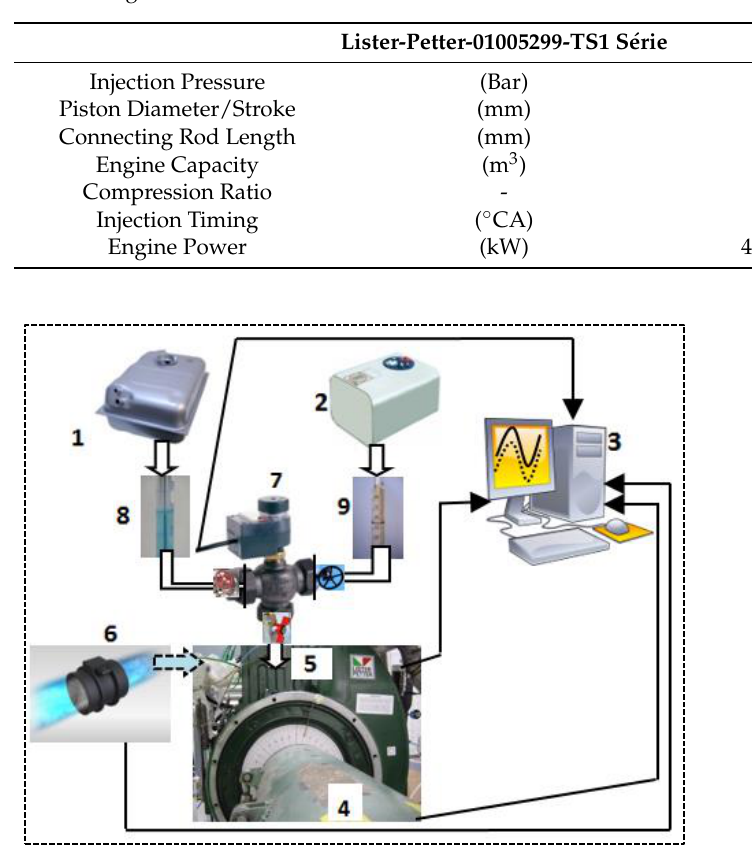
Figure 1. Experimental setup. Legend; 1. Diesel fuel tank; 2. Biodiesel tank; 3. High-frequency acquisition system and computer; 4. Brake dumb dynamometer; 5. Diesel monocylindric motor; 6. Debimeter and air flow sensor; 7. Three-way valve with a purge system; 8. Diesel burette; 9. Biodiesel burette.